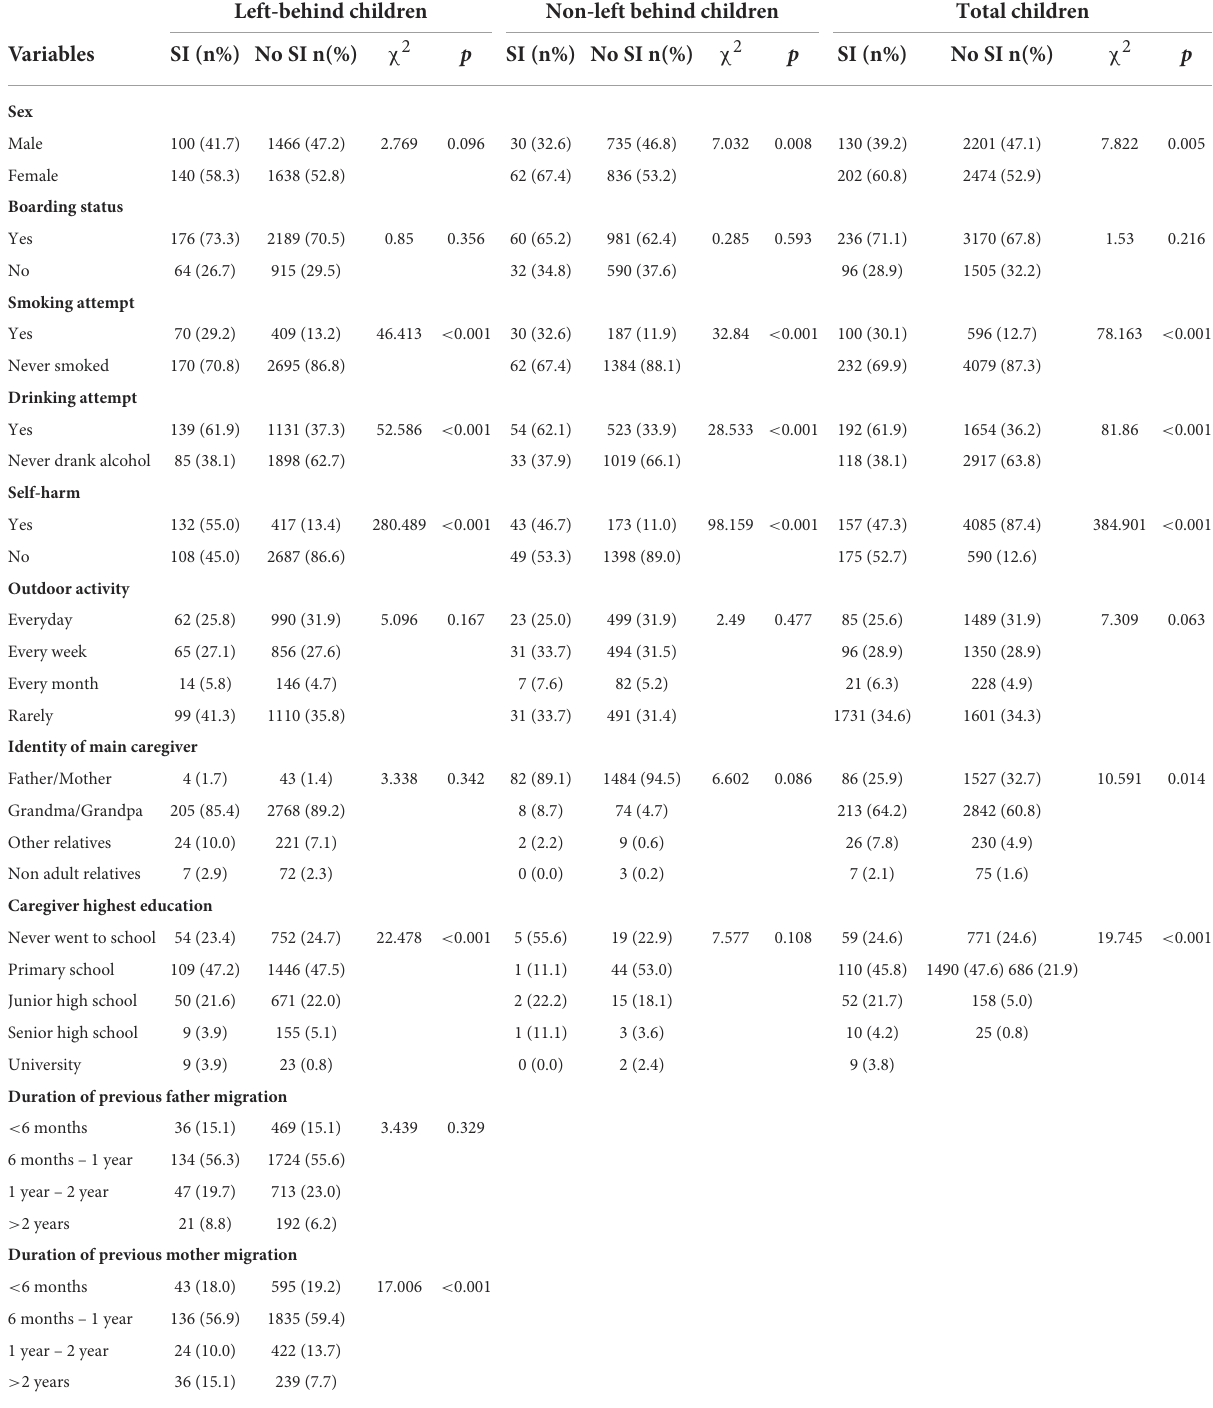
TABLE 5 Suicidal ideation stratified by demographic characteristics, smoking attempt, previous alcohol use, and self-harm in LBC and NLBC. Left-behind children Non-left behind children Total